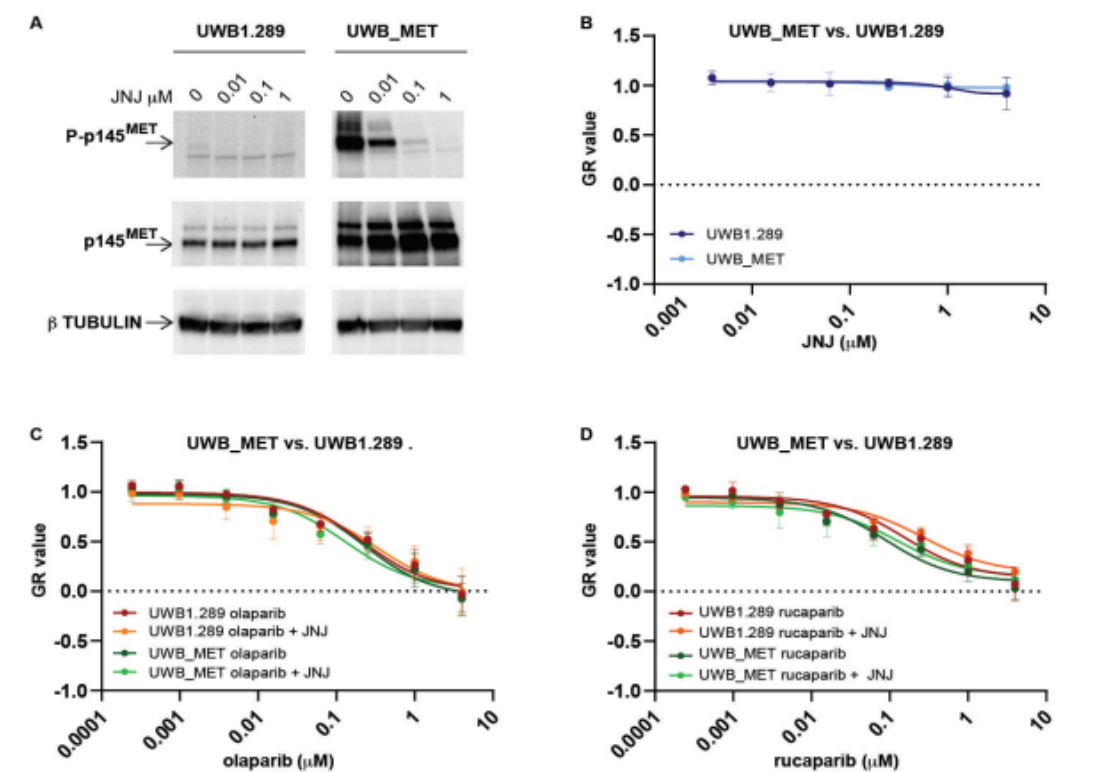
Figure 4. Growth rate of UWB1.289 cells transduced to overexpress the MET receptor (UWB_MET), treated with PARP inhibitors with or without the MET inhibitor JNJ-38877605 (JNJ), evaluated using a 5-day crystal violet assay. Normalized growth rate (GR value) inhibition metrics have been used as described in the legend to Figure 2. ( A ) Expression (p145) and phosphorylation status (P-p145) of the 145 kDa MET receptor subunit in response to the indicated μ M concentration of the inhibitor JNJ-38877605 (JNJ). On the left, un-transduced UWB1.289 cells; on the right, UWB1.289 cells transduced with the wild-type MET transgene (UWB_MET) to overexpress the receptor. β tubulin was used as loading control. ( B ) Growth rate of the UWB1.289 and UWB_MET cells treated with the MET inhibitor JNJ (2 µ M). ( C , D ) Growth rate of the UWB1.289 and UWB_MET cells treated with either the PARP inhibitor olaparib ( C ) or rucaparib ( D ) at the indicated concentrations with or with- out the MET inhibitor JNJ (2 μ M).